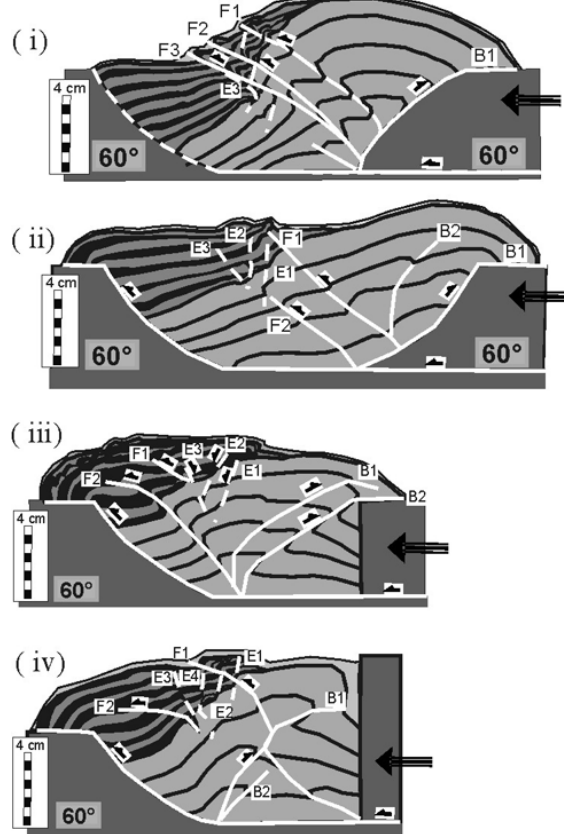
dippingfootwallbutwithdifferentbackstopgeometriesforcomparison of thrust